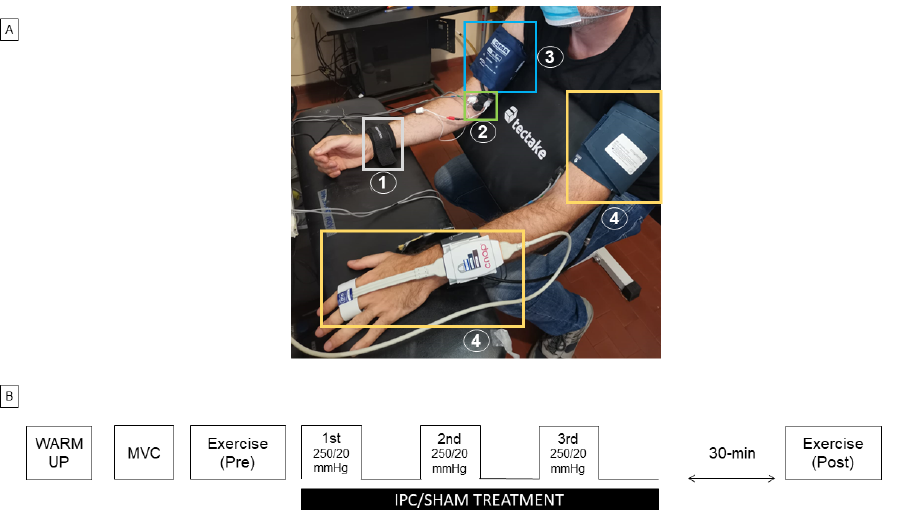
Figure 1. Experimental Setup ( A ). During the measurements, subjects were sitting on an adapted armchair, specific for the fitness training. The subject rested his forearms on a horizontal support. A load cell (not visible) was connected to the right wrist by a wristband (1). Near infrared spectroscopy probe and EMG electrodes (2) were located on the distal end of the bicep’s brachii muscle, and the pneumatic cuff for ischemic pre-conditioning was located proximally on the right arm (3). Non-invasive blood pressure monitoring was applied to the left arm at the fingers, with a pneumatic cuff around the arm for calibration (4). Schematic representation of the experimental protocol ( B ). MVC = maximal voluntary contraction; IPC = ischemic preconditioning: 3 × (5 min ON, 5 min OFF, cuff pressure: 250 mmHg); SHAM = sham intervention: 3 × (5 min ON, 5 min OFF, cuff pressure: 20 mmHg). The exercise consisted of unilateral intermittent isometric elbow flexions (3-s ON, 3-s OFF) at 80% MVC until